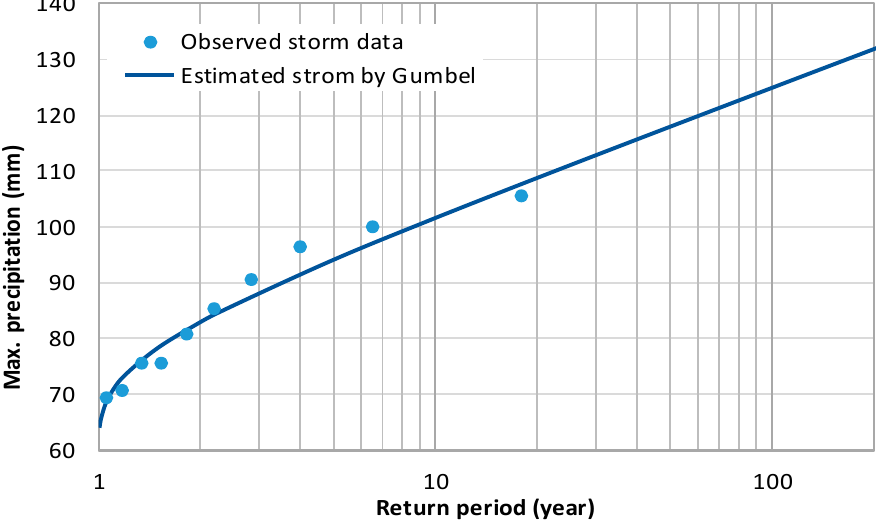
Figure 4. Frequency analysis using Gumbel frequency factors (Kesem, 2006 to 2015).